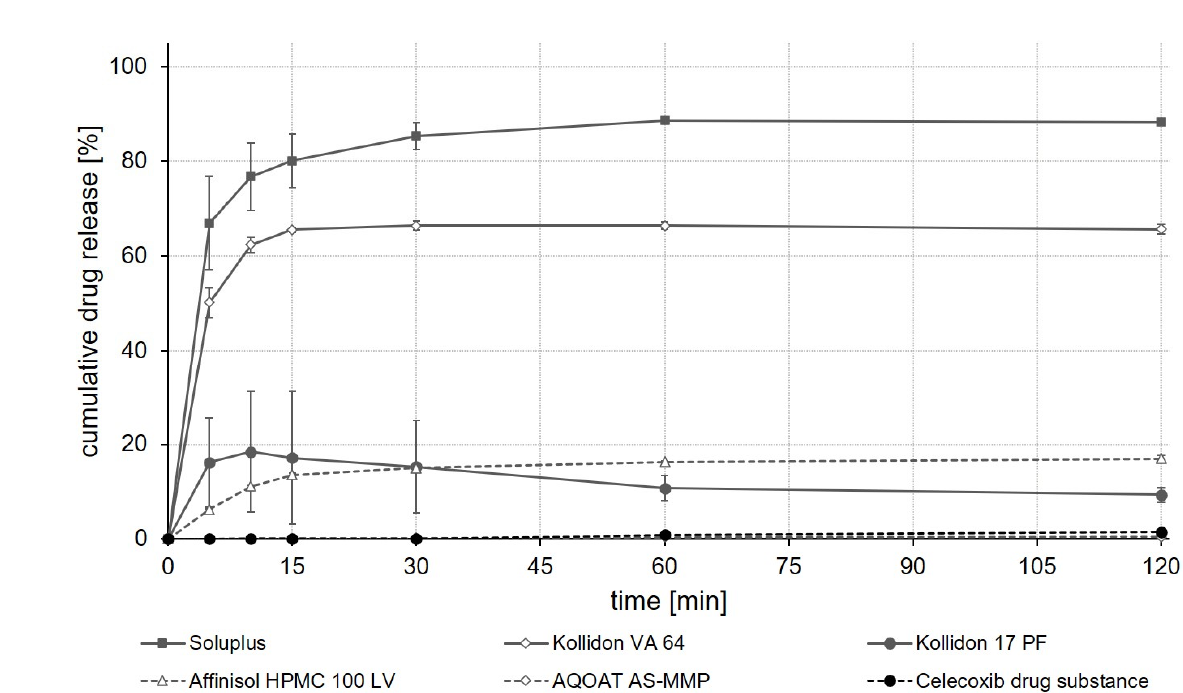
Figure 6. Dissolution profiles of celecoxib drug substance and celecoxib ASDs based on ModE and EPO ( a ), as well as celecoxib drug substance and celecoxib ASDs based on other marketed (co-)polymers ( b ) in 500 mL 0.1 M HCl in USP apparatus II. Each value designates the mean ± S.D. (n = 3).